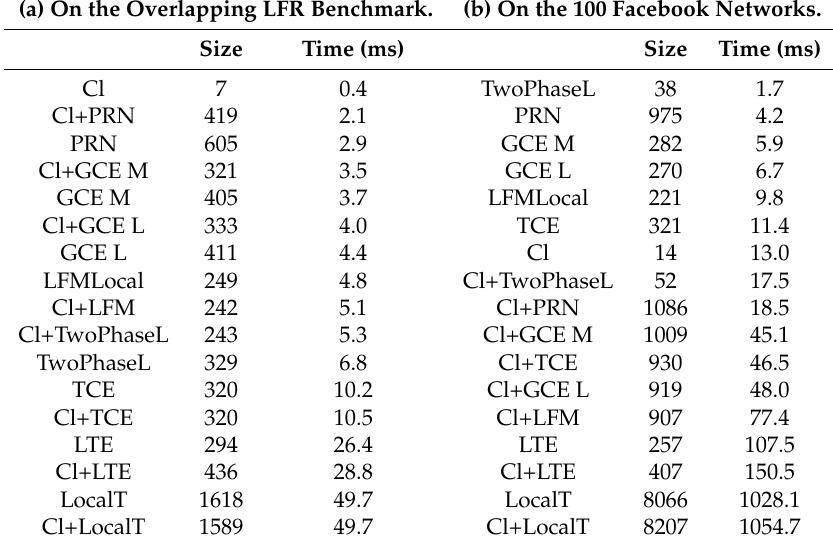
Table 2. Average times (ms) per seed node and average community sizes of the algorithms. (a) On the Overlapping LFR Benchmark. (b) On the 100 Facebook